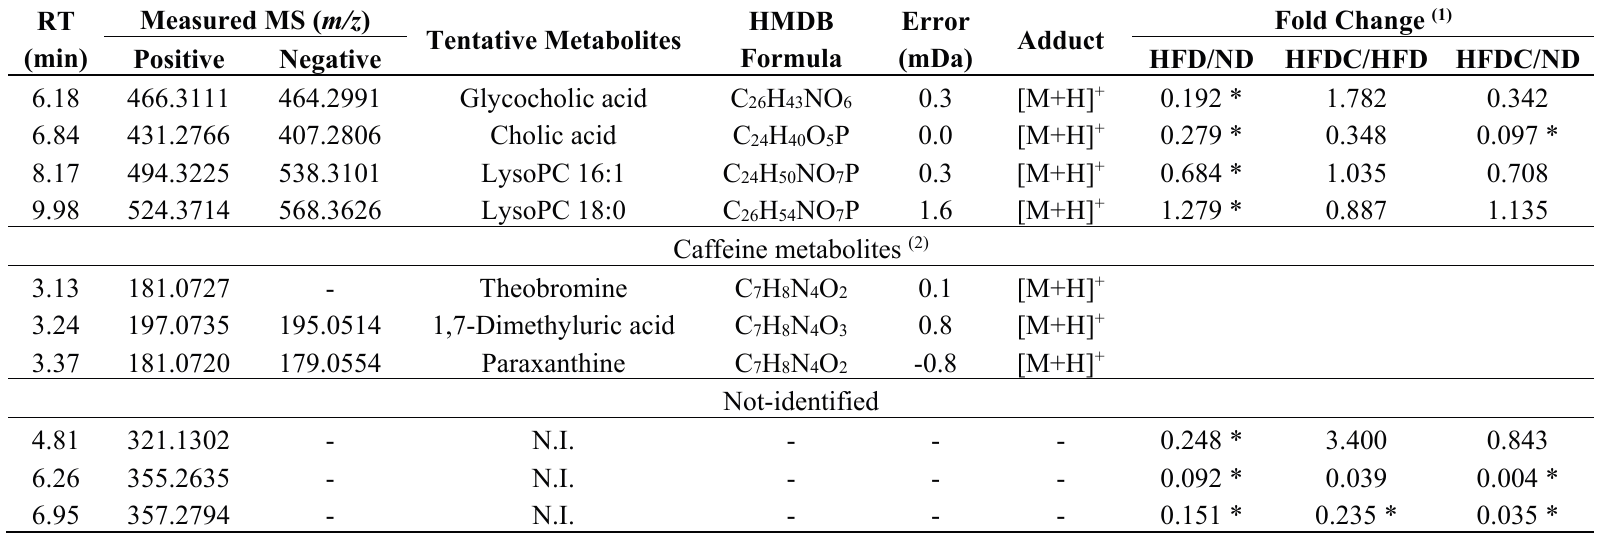
Table 4. Discriminated metabolites of the serum identified using